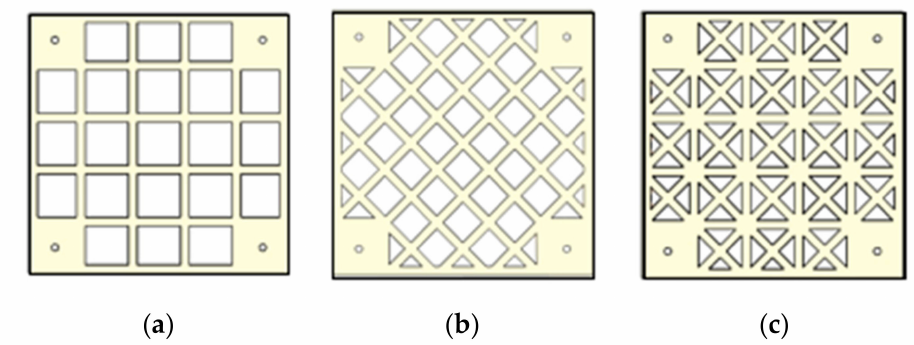
Figure 5. Shape of ABS polymer board: ( a ) O type; ( b ) W type; ( c ) X type.